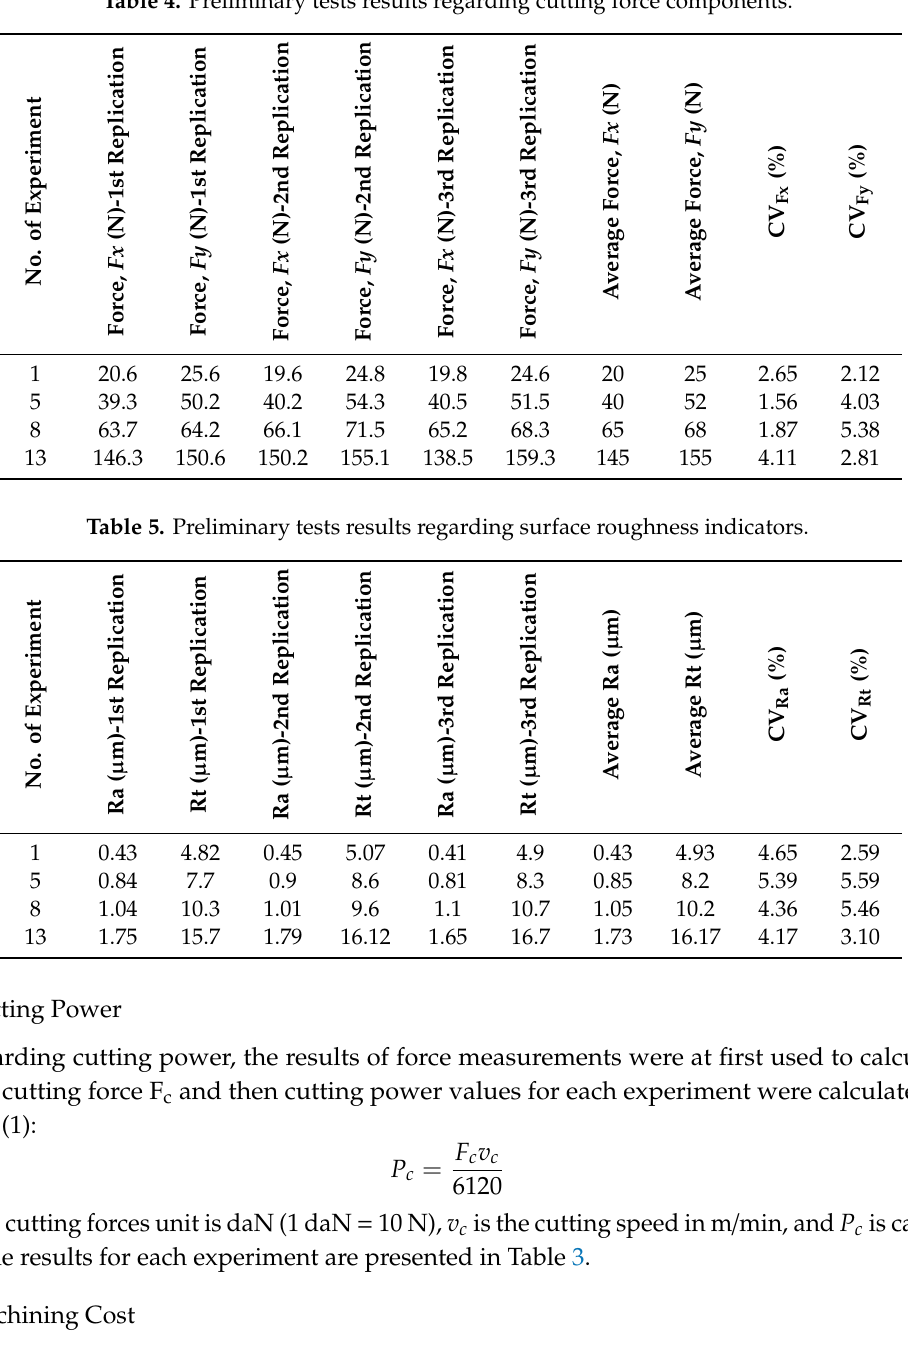
Table 4. Preliminary tests results regarding cutting force components.